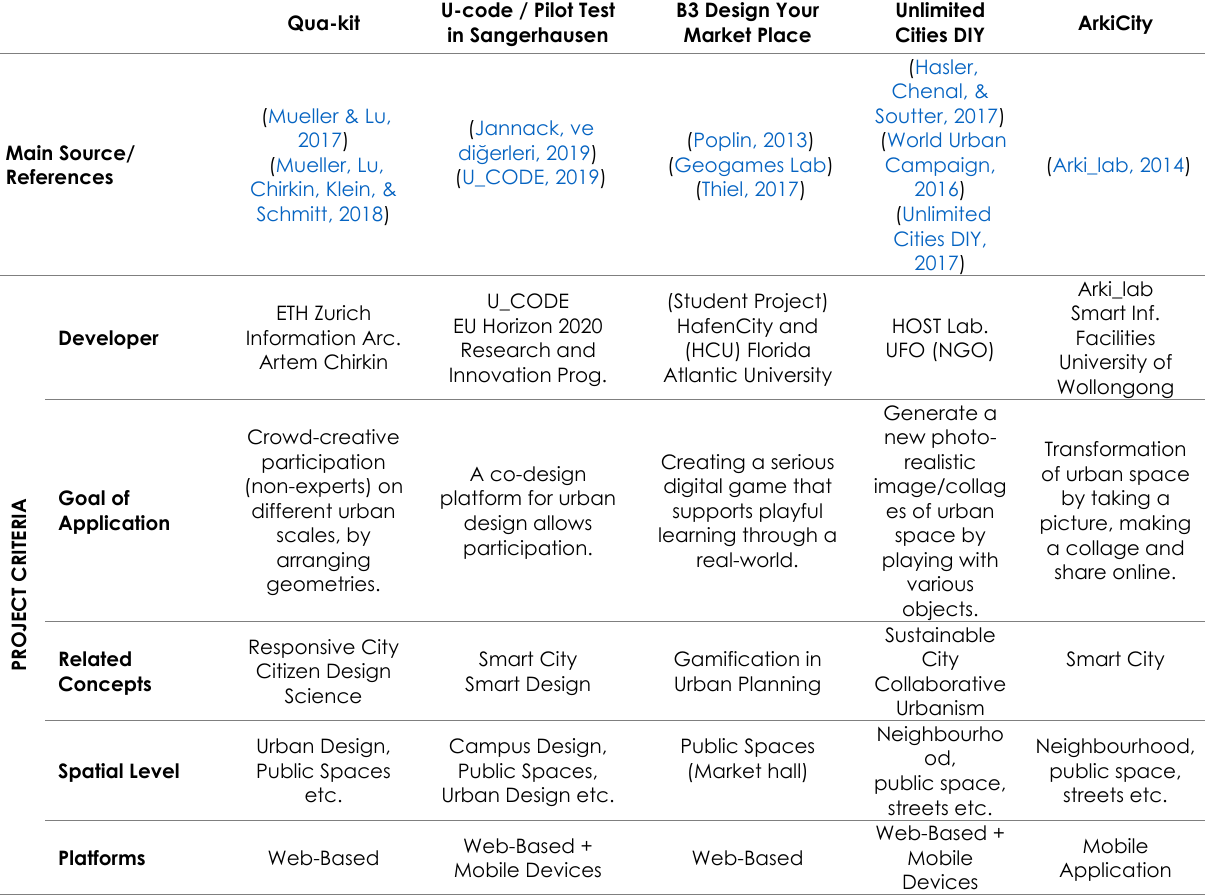
Table 4. Examination of Platforms and Applications that Enable Citizen